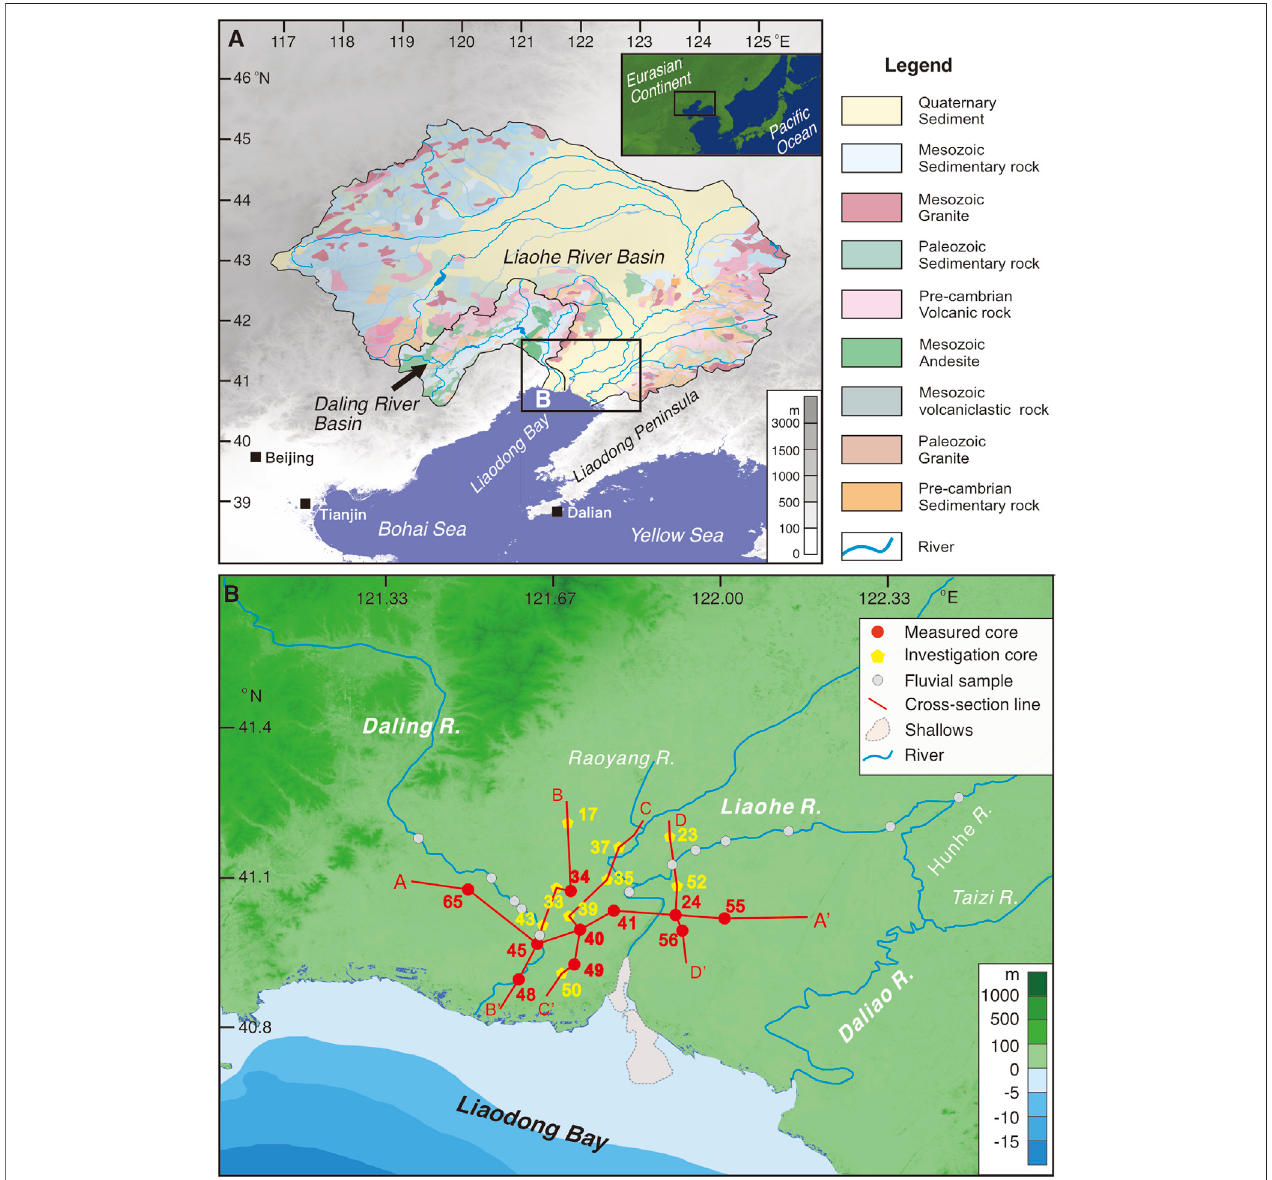
FIGURE 1 | (A) Study area of the North Bohai Coast and bedrock types of the Liaohe and Daling rivers ’ drainage basins. (B) Fluvial system, sampling sites of the sediment cores, and the modern fl uvial sediments.